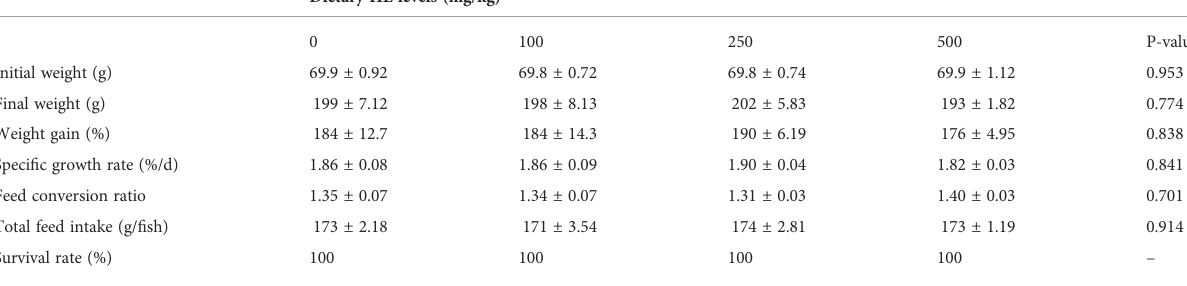
TABLE 4 Growth performance and feed ef fi ciency of rainbow trout fed diets supplemented with 0-500 mg/kg HE over eight weeks (mean ± SE; n =